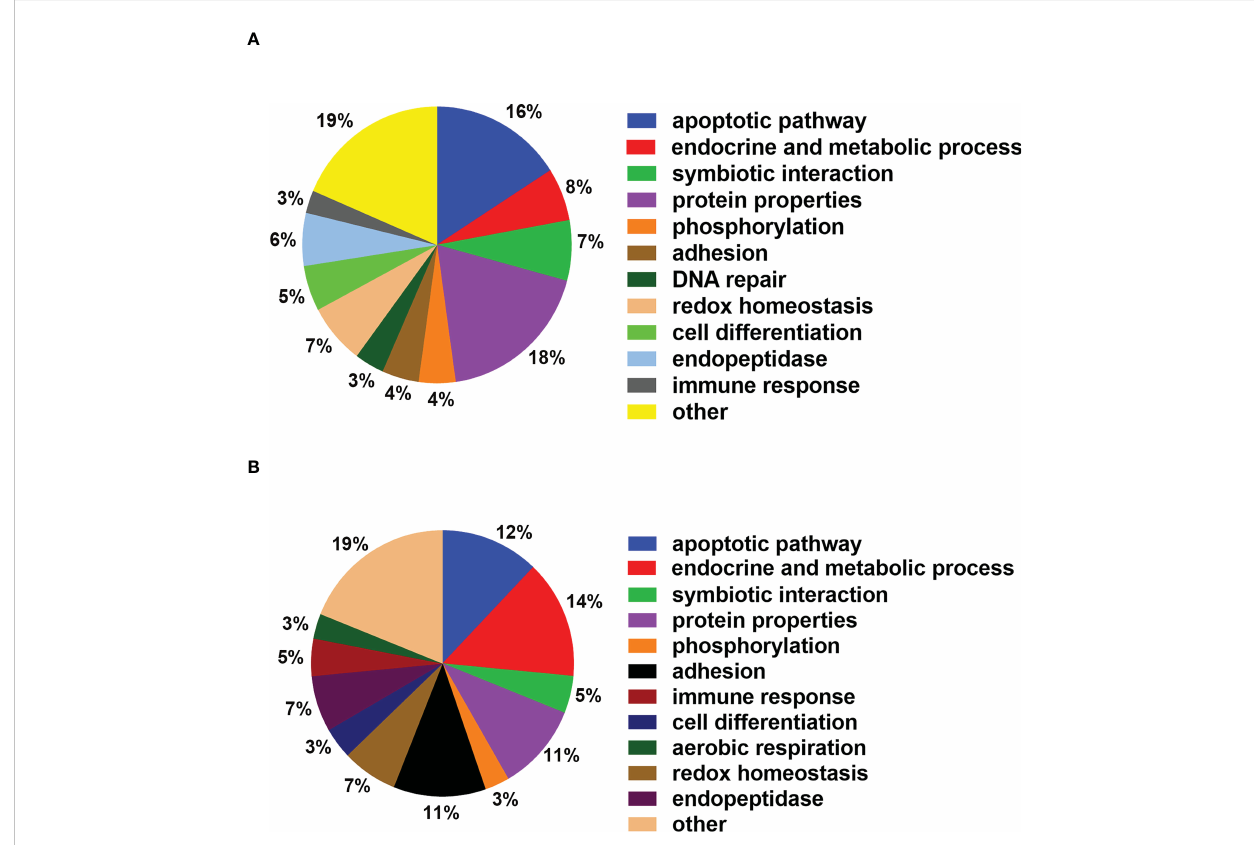
FIGURE 6 Main biological functions of SNO proteins. (A) Proportion of SNO protein detected in SW 480 participating in main biological processes. (B) Proportion of SNO protein detected in human cancer tissue participating in main biological